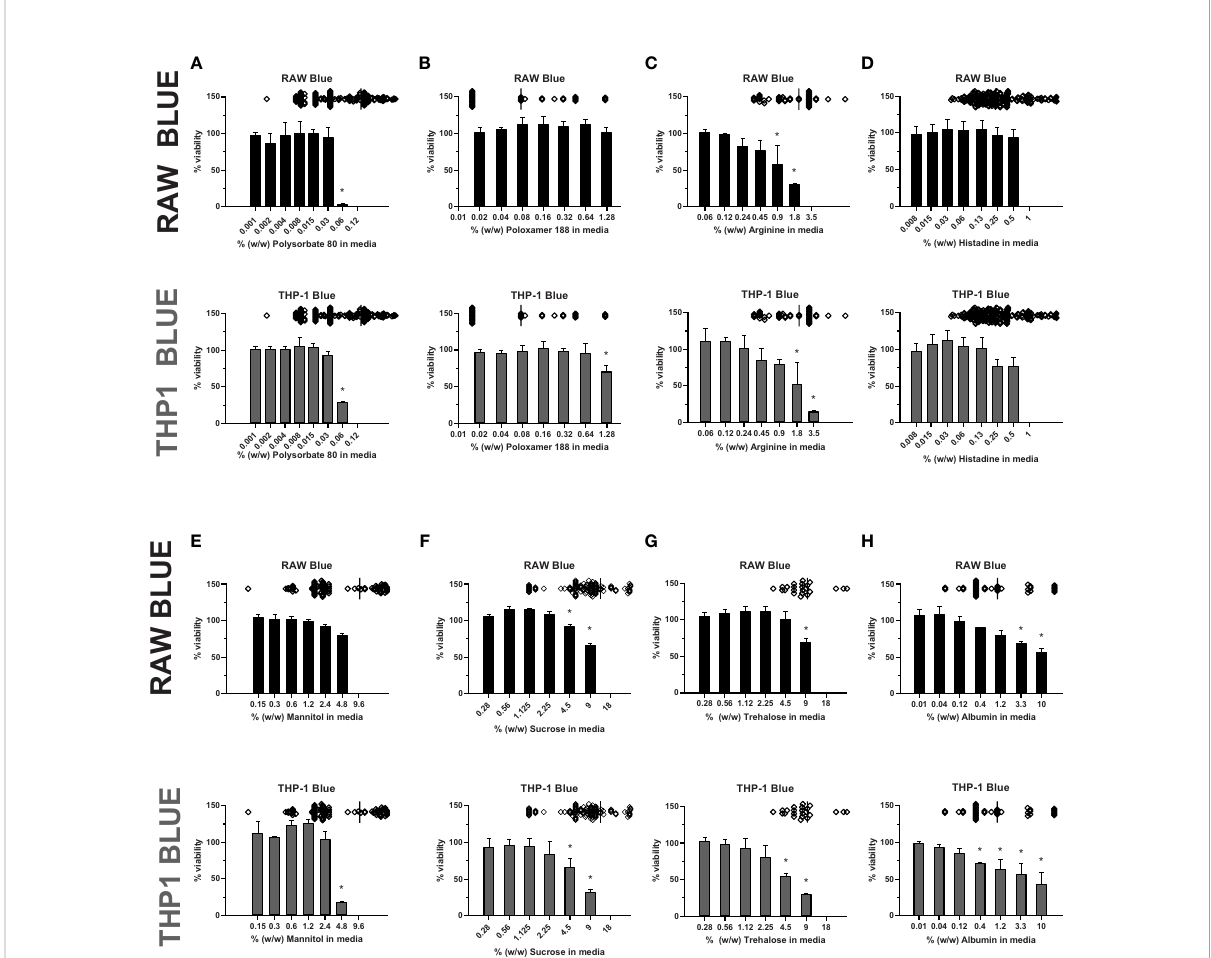
FIGURE 1 Excipient effect on cell viability. RAW-Blue and THP-1-Blue cells were incubated in triplicate with increasing concentrations of (A) Polysorbate 80, (B) Poloxamer 188, (C) Arginine, (D) Histidine, (E) Mannitol, (F) Sucrose, (G) Trehalose, or (H) Albumin for 24 hours. Top of each graph: Scatter plot depicting concentration of the excipient in licensed biological drugs regulated by the Of fi ce of Biotechnology Products at the FDA for reference. Cell metabolism/viability was assessed using the CCK8 assay. Results are shown relative to no-excipient control cells. The graph is representative of three independent experiments. Results are presented as the mean ± SD. RAW- and THP-1-Blue cells are solid black or grey, respectively. *p <